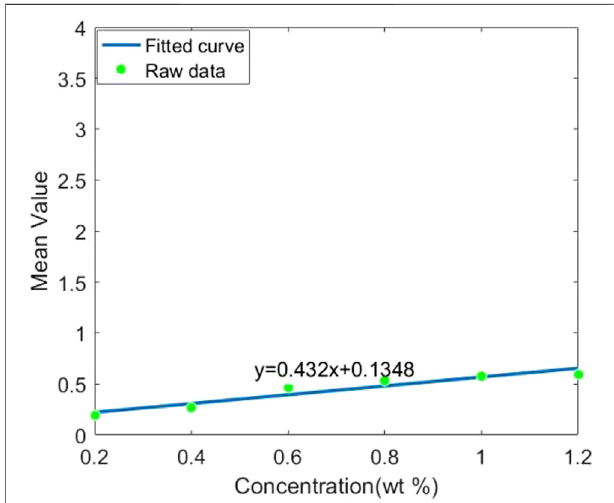
FIGURE 10 | Fluorescence efficiency of Ru.